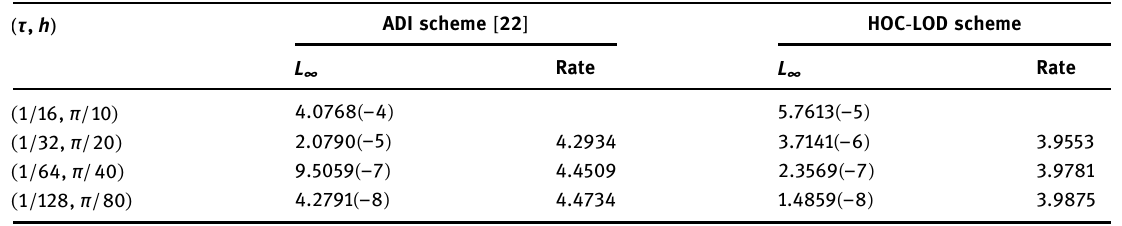
Table 6: L ∞ error and rate when = T 1 for di ff erent h and τ for Example